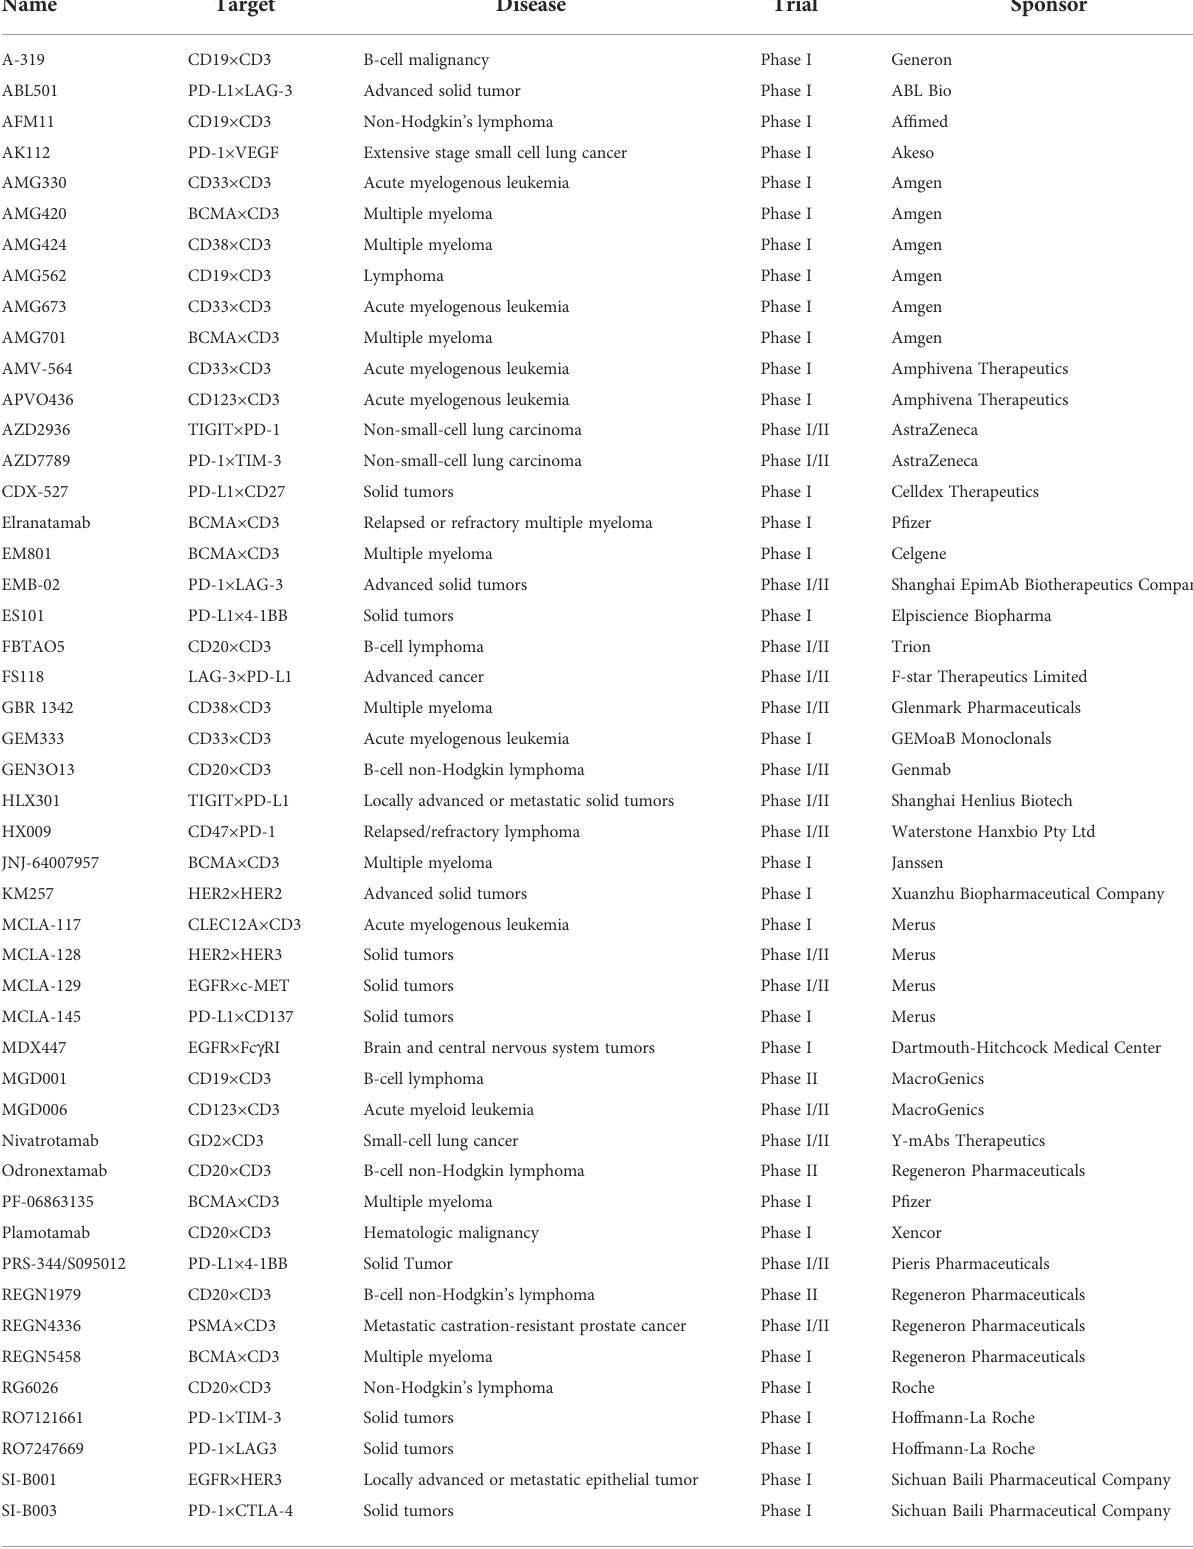
TABLE 3 Bispeci fi c antibodies in clinical